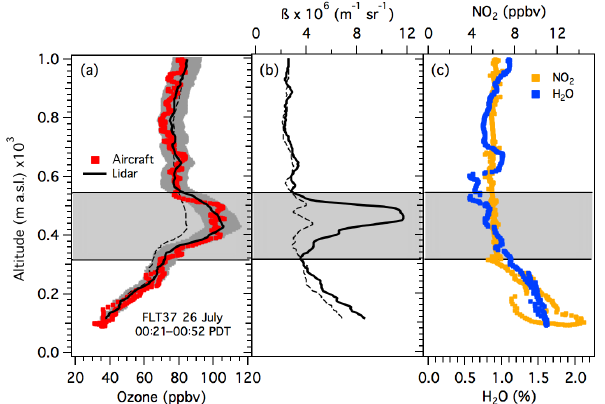
Figure 10. (a) Expanded view of the lidar and aircraft O 3 profiles from Fig. 9e plotted with coincident (b) lidar backscatter and (c) air- craft NO 2 and H 2 O profiles. The solid black profile ( ± 10% in gray) in (a) shows the lidar profile coinciding with the aircraft measure- ments below 1km; the dashed black line shows the profile measured 16–24min later. This is also true for the backscatter profiles in (b) . The horizontal gray band highlights the smoke puff from the Sober- anes